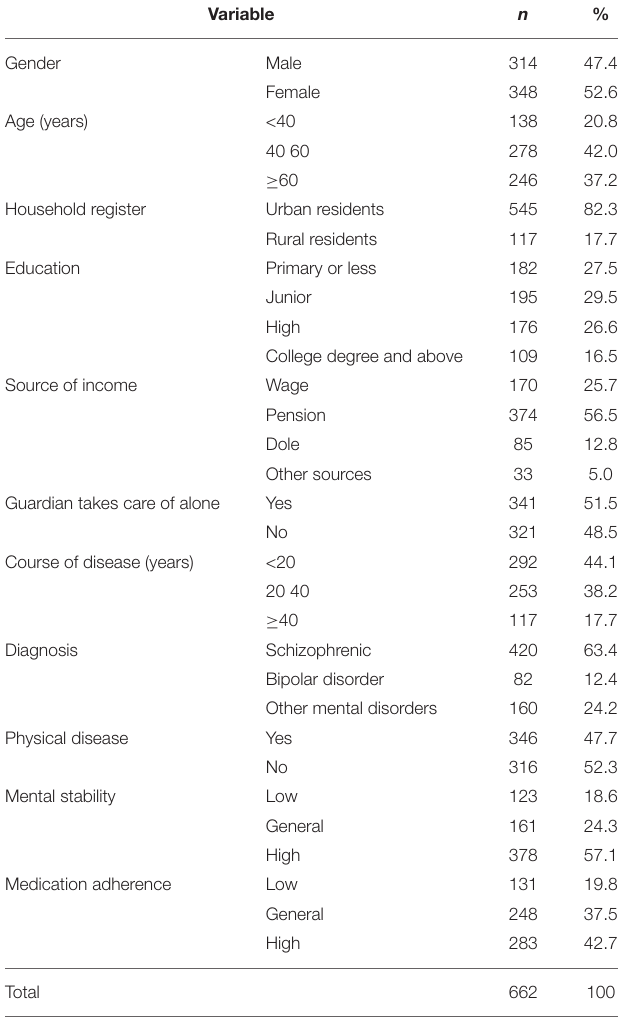
TABLE 1 | Description of respondent